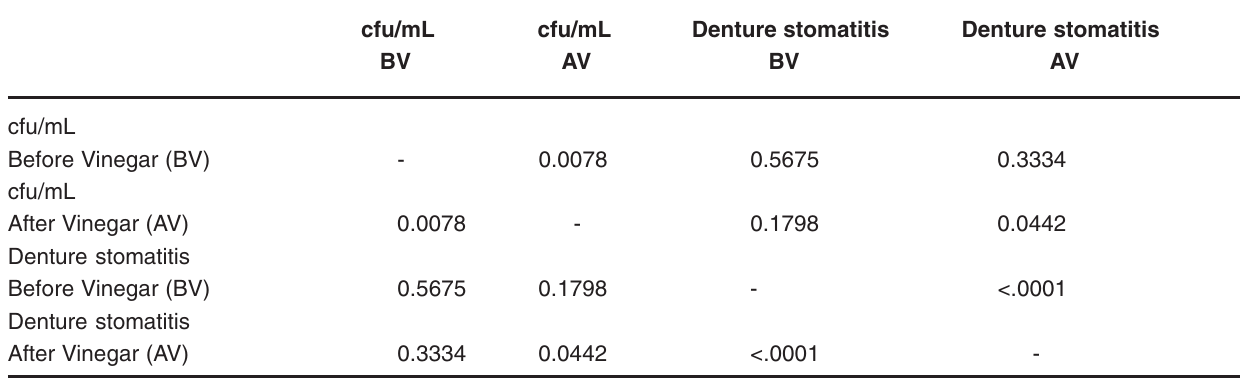
Statistically significant if p ≤